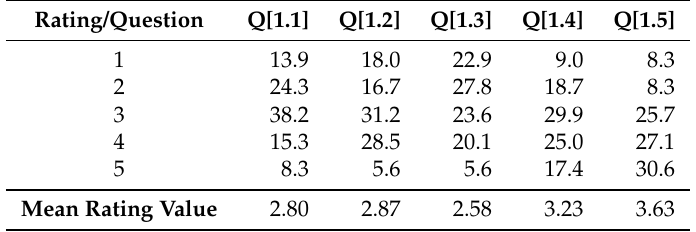
Table 5. Pre-test results (first survey)—percentage (%) of answers per question